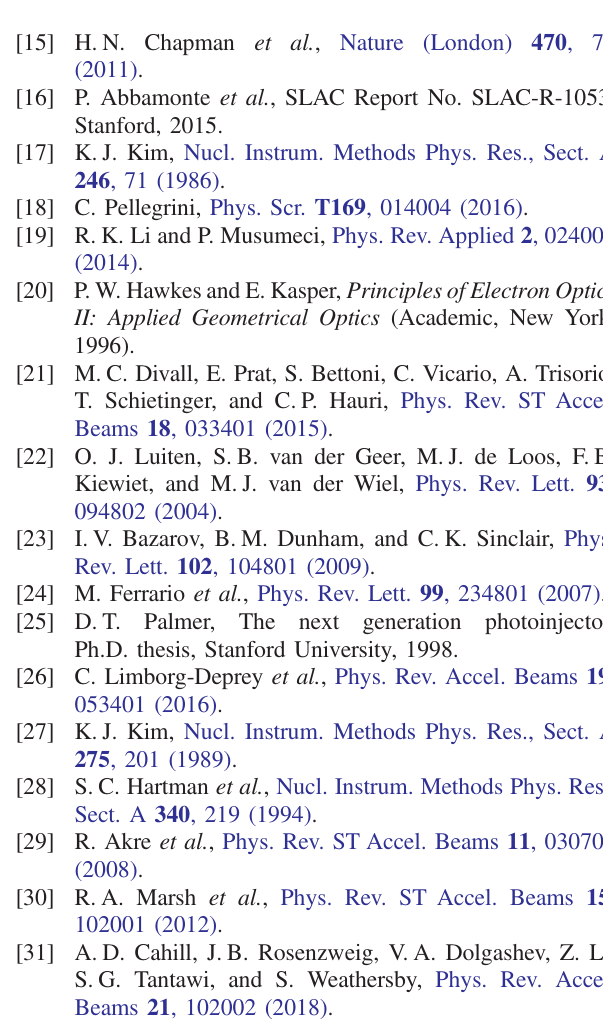
17. (left) Current (normalized to uniform launch current I ¼ 0 . 1 ; (right) current profile strong bunch lengthening limit, showing near suppression of emission with linear limit of emission, α sc α ¼ 0 . 95 sc